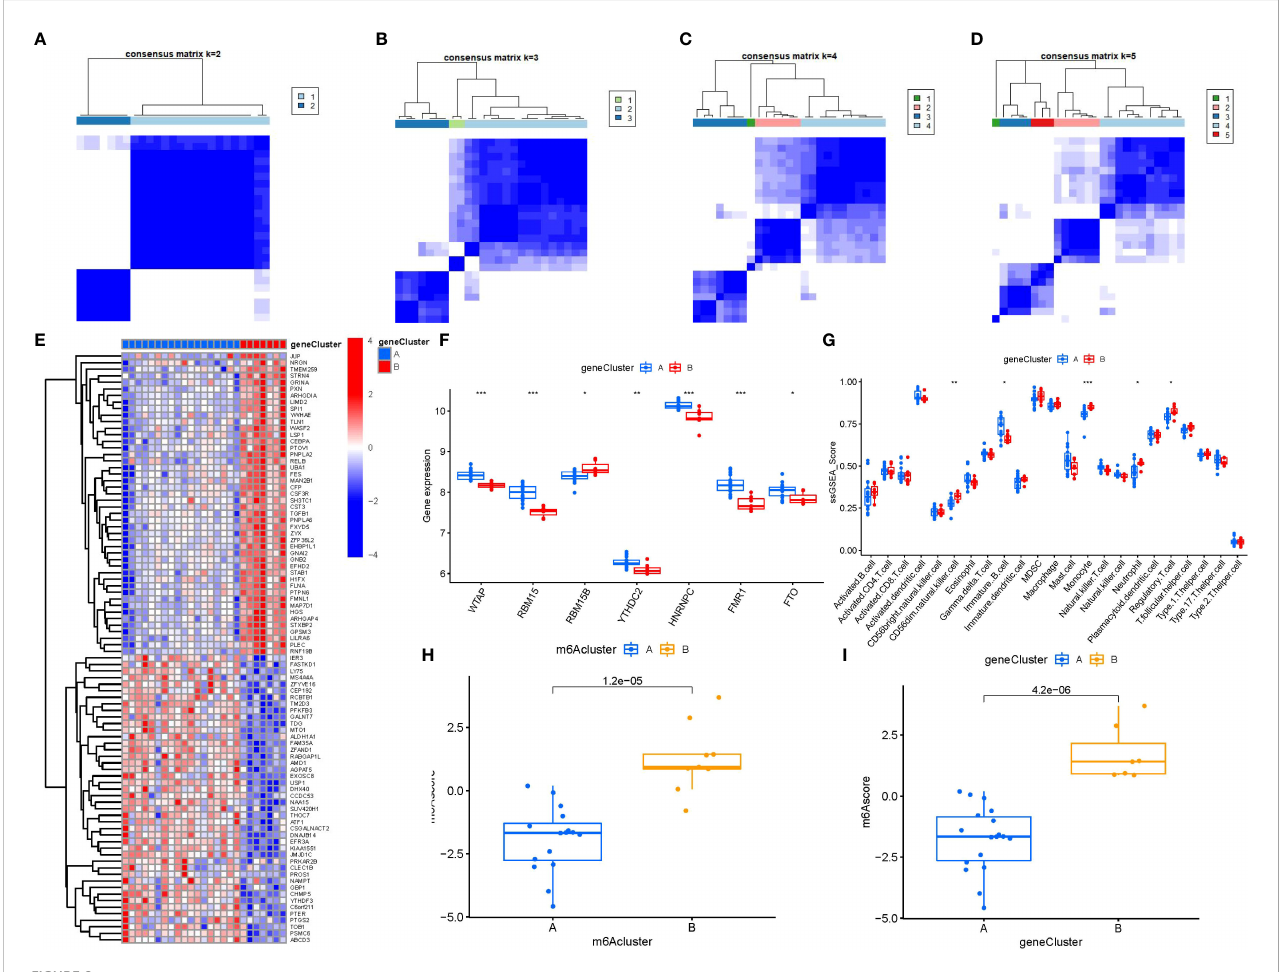
FIGURE 8 Consensus clustering of the 90 m6A-associated DEGs in PMOP. (A – D) Consensus matrices of the 90 m6A-associated DEGs for k = 2 – 5. (E) Expression heat map of the 90 m6A-associated DEGs in gene clusterA and gene clusterB. (F) Differential expression boxplots of the 7 signi fi cant m6A modulators in gene clusterA and gene clusterB. (G) Differential immune cell in fi ltration between gene clusterA and gene clusterB. (H) Differences in m6A score between clusterA and clusterB. (I) Differences in m6A score between gene clusterA and gene clusterB. *p < 0.05, **p < 0.01, and ***p <